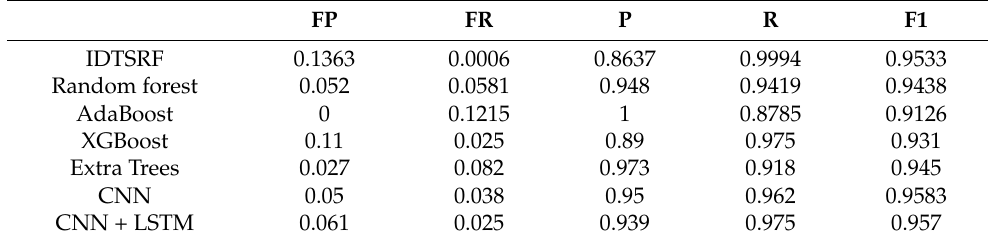
Table 4. IDTSRF running